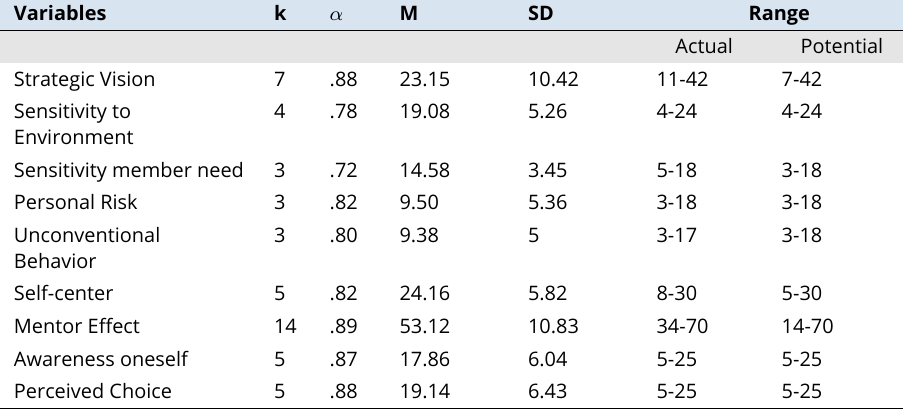
Descriptive statistics and psychometric properties of charismatic leadership, mentoring effectiveness and self-determination